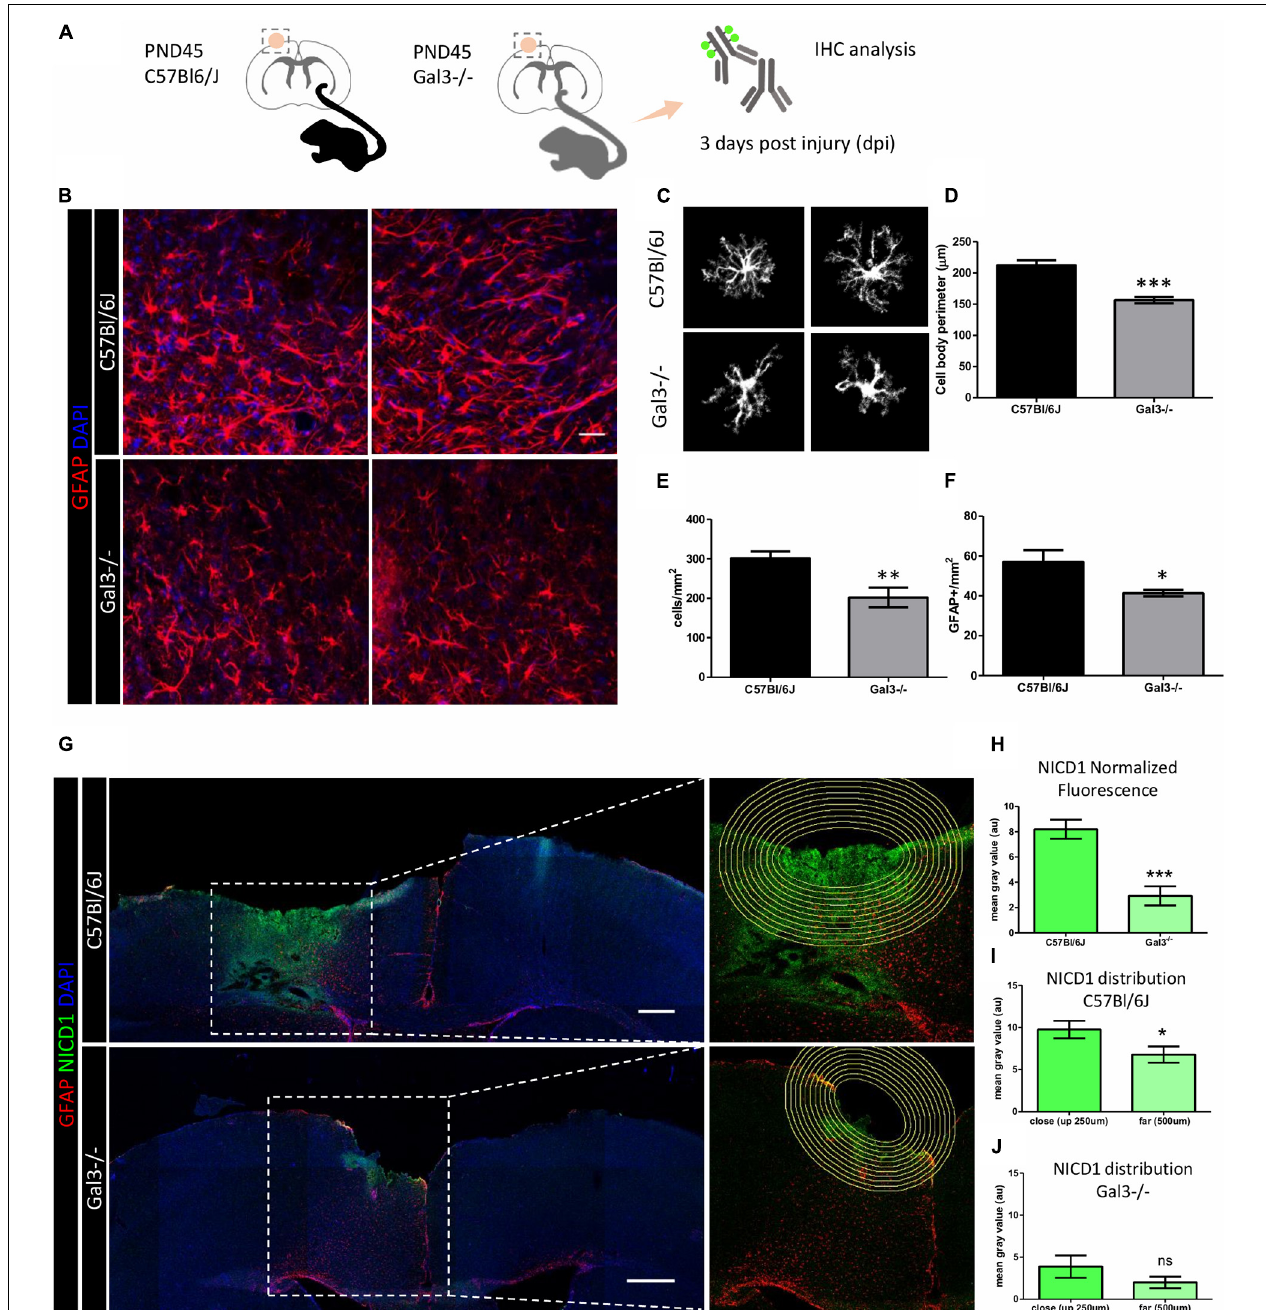
FIGURE 5 | Gal3 − / − mice reactive astrocytes show incomplete response and dysfunctional Notch1 signaling activation following TBI. (A) Experimental design: Adult mice were submitted to a penetrating stab wound injury at the somatosensorial cortex and tissue sections were processed 3dpl for GFAP and NICD1 immunolocalization. (B) Representative confocal images of GFAP staining at TBI core. Scale bar: 50 µ m. C57BL/6J reactive astrocytes extend primary branches to the lesion core and acquire a bipolar morphology. In contrast, Gal3 − / − reactive astrocytes do not polarize to the lesion core. (C,D) Gal3 − / − reactive astrocytes show less complex morphology and smaller cell bodies compared to C57BL/6J reactive astrocytes (*** p ≤ 0.0001, unpaired t -test, n = 20 cells C57BL/6J / 20 Gal3 − / − cells). Quantification of the number of cells around the lesion core revealed (E) fewer cells per mm 2 (** p ≤ 0.01, unpaired t -test, n = 11 C57BL/6J cells / 10 Gal3 − / − cells) and (F) fewer GFAP + cells per mm 2 (* p ≤ 0.05, unpaired t -test, n = 11 C57BL/6J cells / 10 Gal3 − / − cells). (G,left) Mosaic composition of TBI confocal images showing NICD1 distribution at the lesion core. Scale bar: 500 µ m. (G,right) Zoom image of the section. Concentric circles with 50 µ m distance between each one were drawn around the lesion core and used to quantify NICD1 labeling intensity (H–J) . (H) NICD1 immunolabeling is more intense up to 500 µ m from the lesion border in C57BL/6J mice than in Gal3 − / − mice (*** p ≤ 0.001, unpaired t -test). (I) In C57BL/6J mice, NICD1 fluorescence intensity is stronger in cells closer to the lesion border (up to 250 µ m) compared to the cells that are farther away from the border of the lesion (250 µ m to 500 µ m) (* p ≤ 0.05, unpaired t -test). (J) NICD1 close/far distribution is not seen in Gal3 − / − mice (ns = not significant).